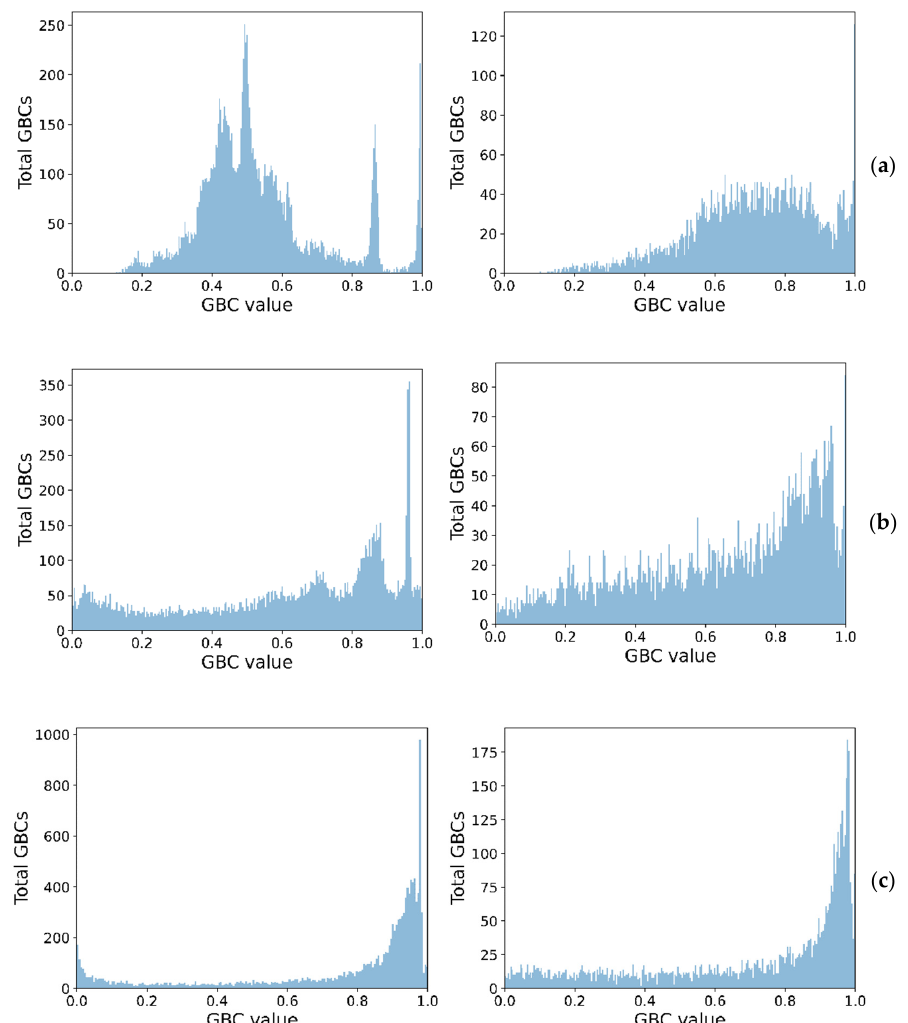
Figure 4. Spread of GBC values for the two classes (unimodal left , bimodal right ) on the synthetic